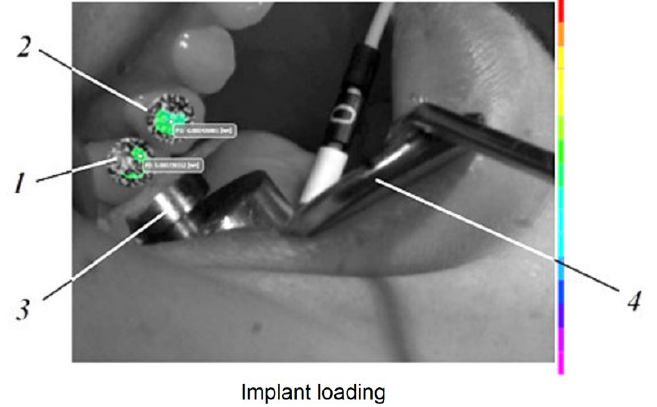
Figure 1. The Implant’s loading capture: 1 —loaded tooth (implant); 2 —unloaded tooth (natural tooth); 3 —load cell; 4 —Farabeuff retractor.